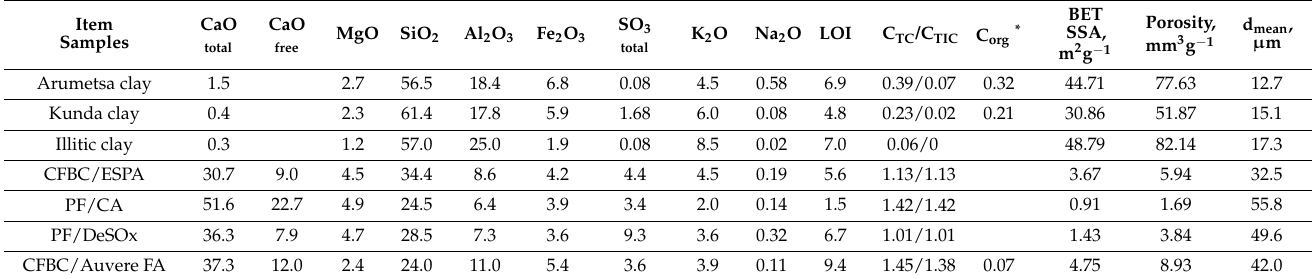
Table 2. Chemical composition (%) and some physical characteristics of initial